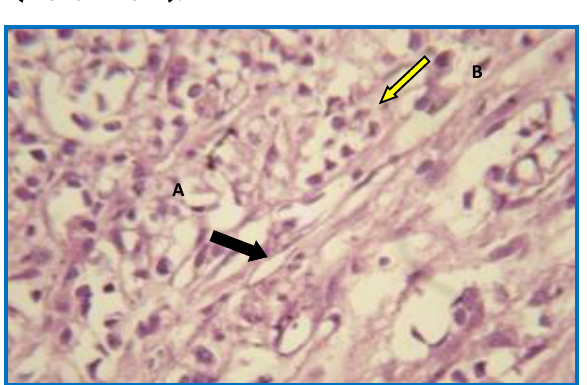
Figure, 10: Shows granulation tissue (A) with neutrophils in blood vessel lumen (B). Group A, fifteen days post operation (H and E 40 X).